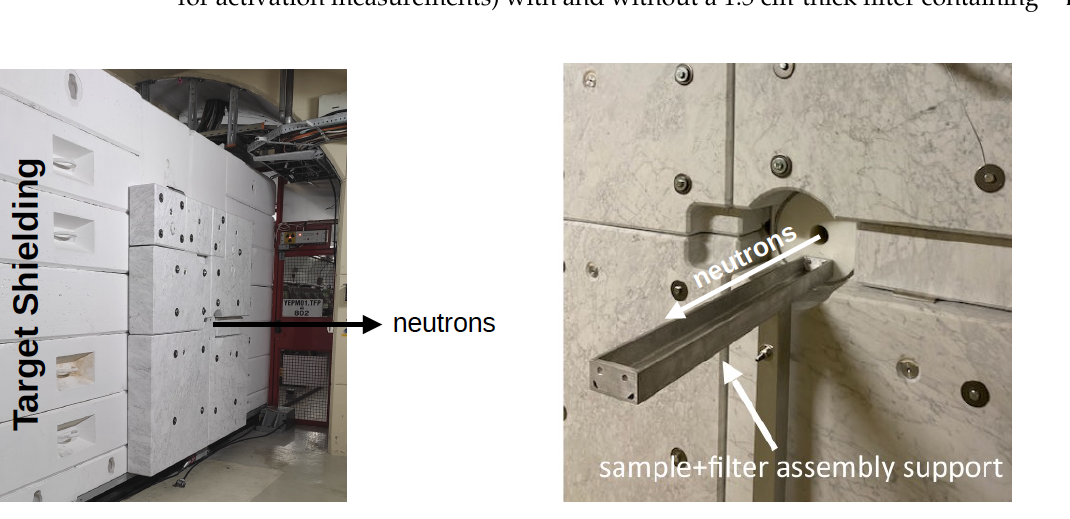
Figure 5. View of the concrete and marble shielding around the spallation target ( left panel ) and the zoom on the irradiation position at NEAR ( right panel